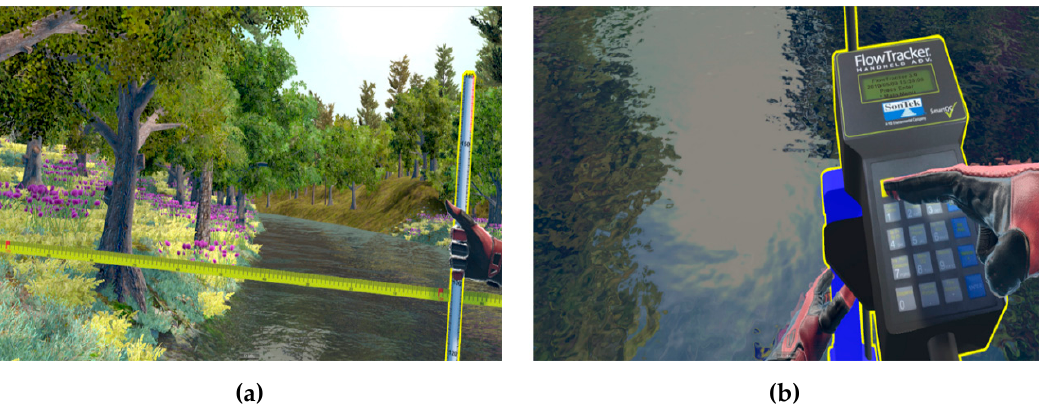
Figure 5. Examples of ( a ) the sounding rod and ( b ) the Acoustic Doppler Velocimeter highlighted in yellow at the user’s touch.